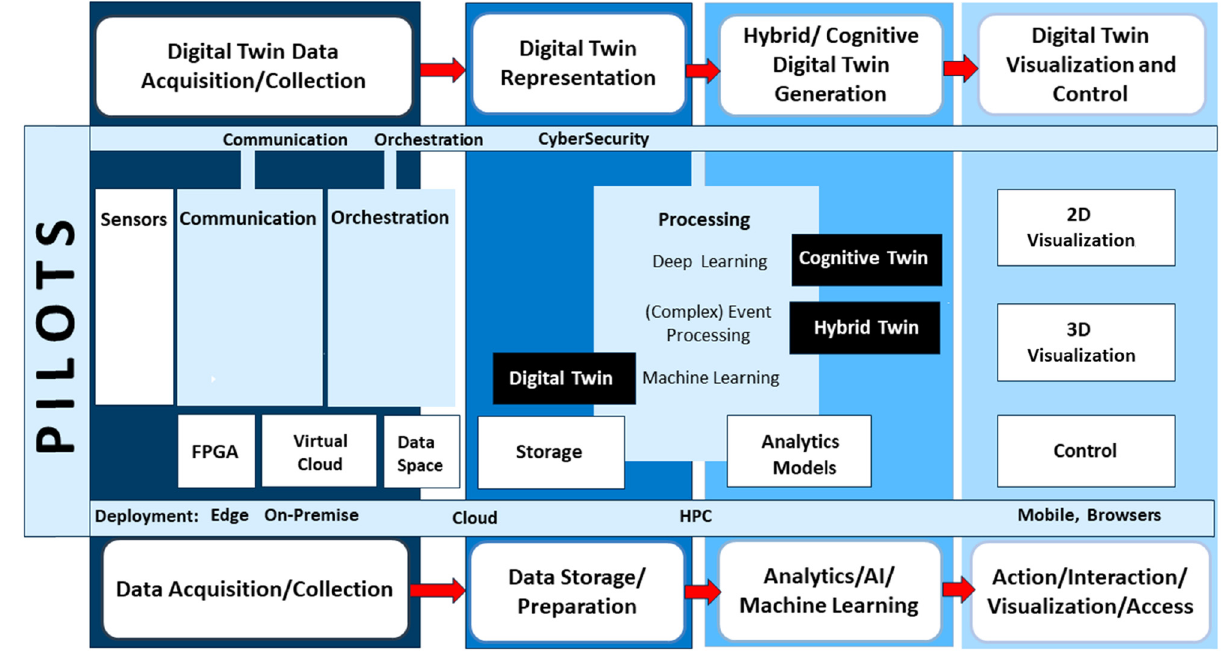
Figure 1: COGNITWIN Digital twin pipeline [ 21 ] .